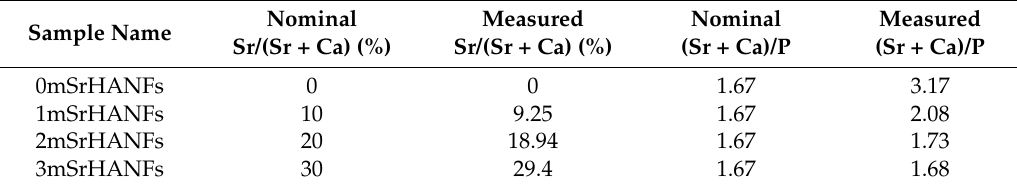
Table 2. Elemental composition of different samples measured by inductively coupled plasma–optical emission spectrometry (ICP-OES).